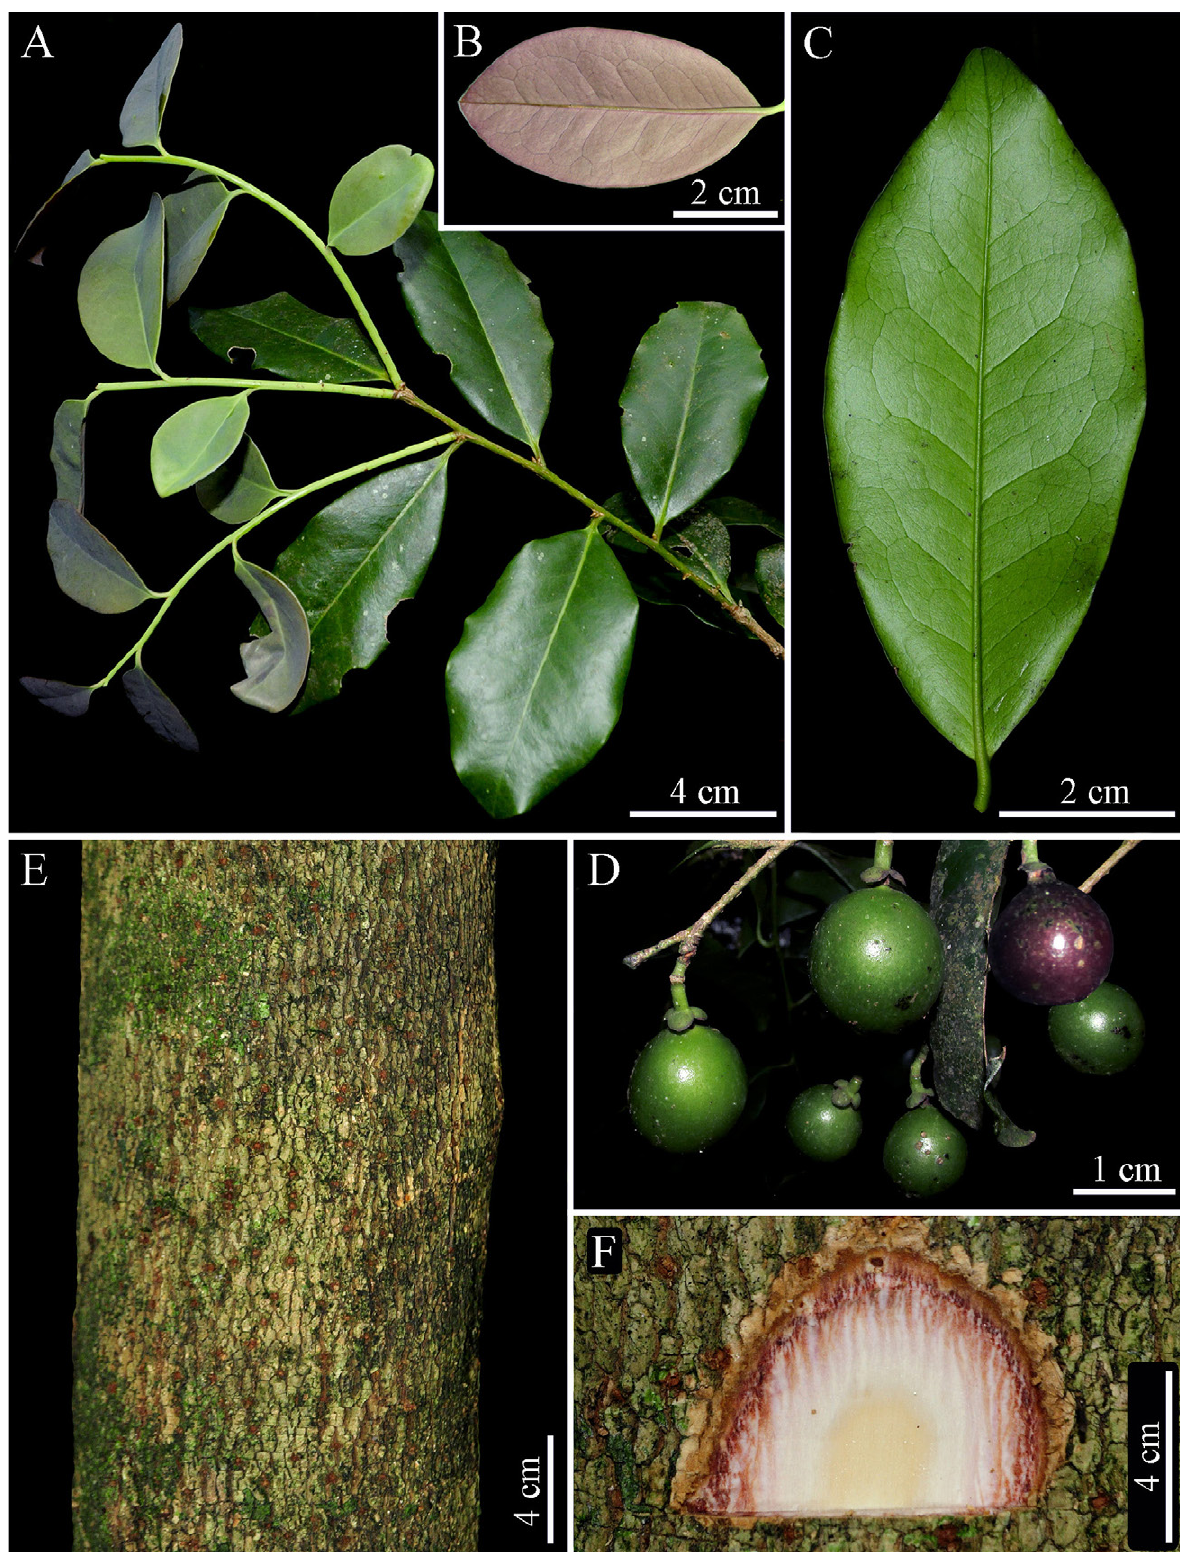
Figure 3. Cinnamodendron occhionianum F.Barros & J.Salazar. A. Branch with young and adult leaves. B. Abaxial surface of young leaf. C. Abaxial surface of adult leaf. D. Branch with immature and mature fruits. E. Bark appearance. F. Slash